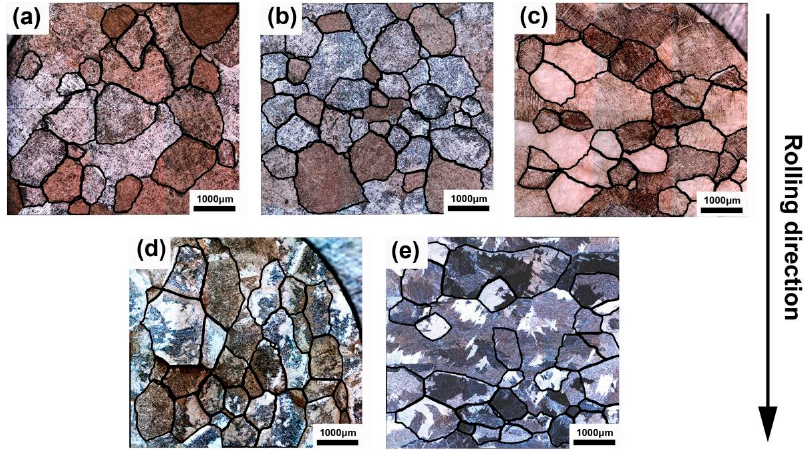
Figure 2. OM images of TC4F after treatment. Samples ( a ) 1, ( b ) 2, ( c ) 3, ( d ) 4 and ( e ) 5.